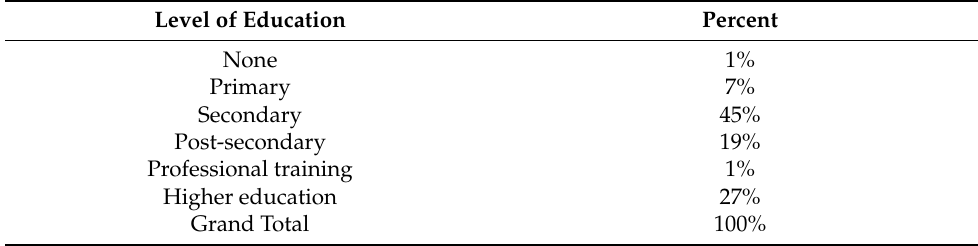
Table 2. Share of participants per level of education.